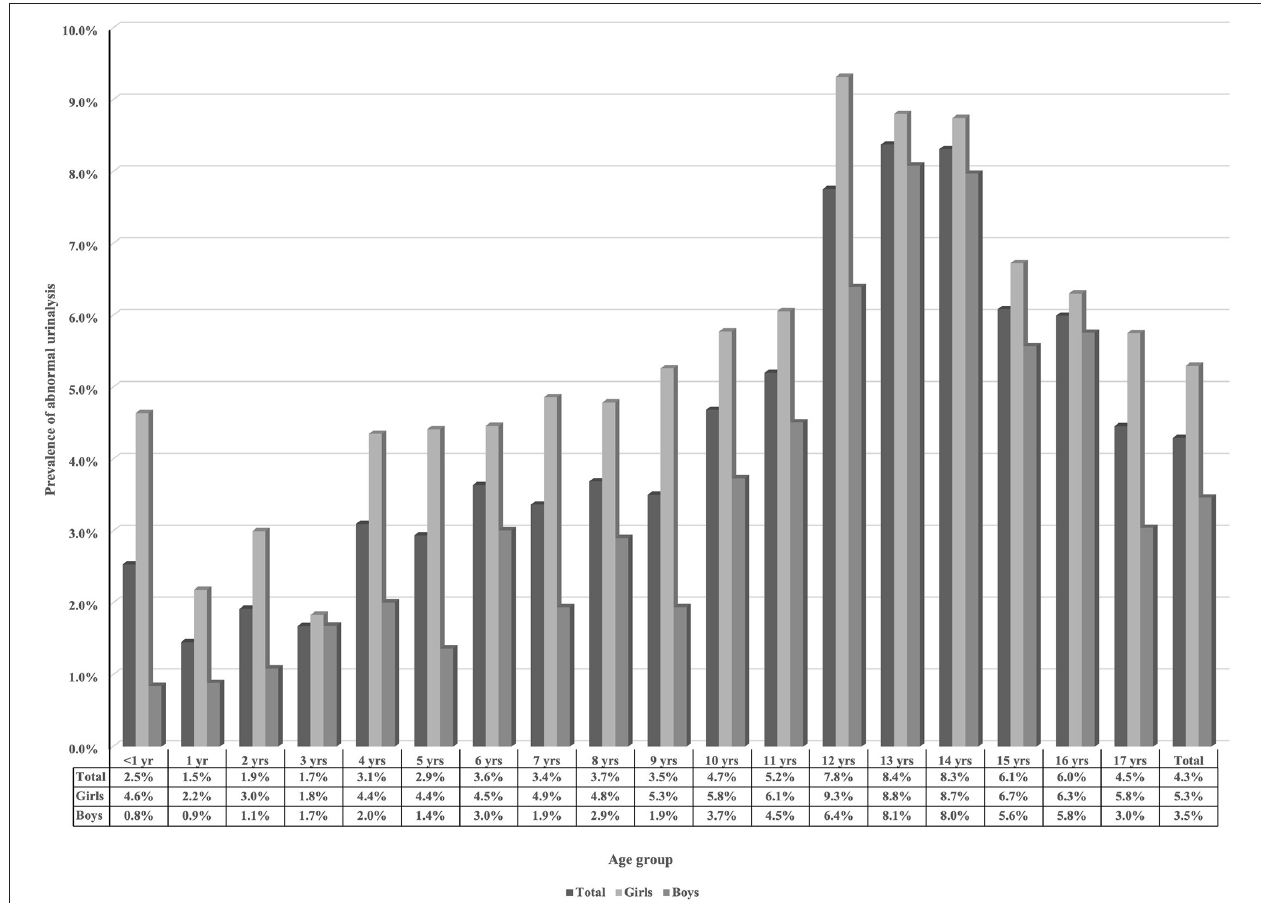
FIGURE 2 | Age and sex distributions of abnormal urinalysis results in